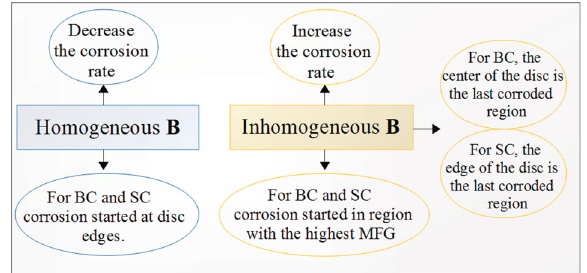
Fig. 7 Schematic summary of the main phenomena observed in the CCL discs, in BC and SC and in presence of inhomogeneous and homogeneous magnetic fi eld. The corrosions in presence of inhomogeneous or homogenous magnetic fi eld were always, respectively, faster and slower than the corrosion in absence of B , independently of the cell size. The corrosion pattern at the end of depends on the cell